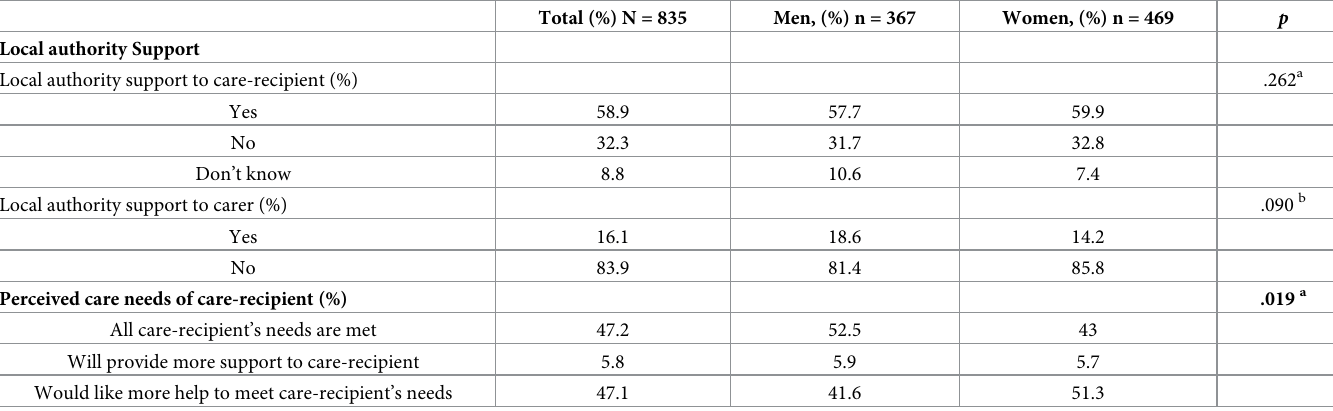
Table 2. Local authority support to care-recipient and carer and carer perceived needs of care-recipient for the total sample of working carers and by